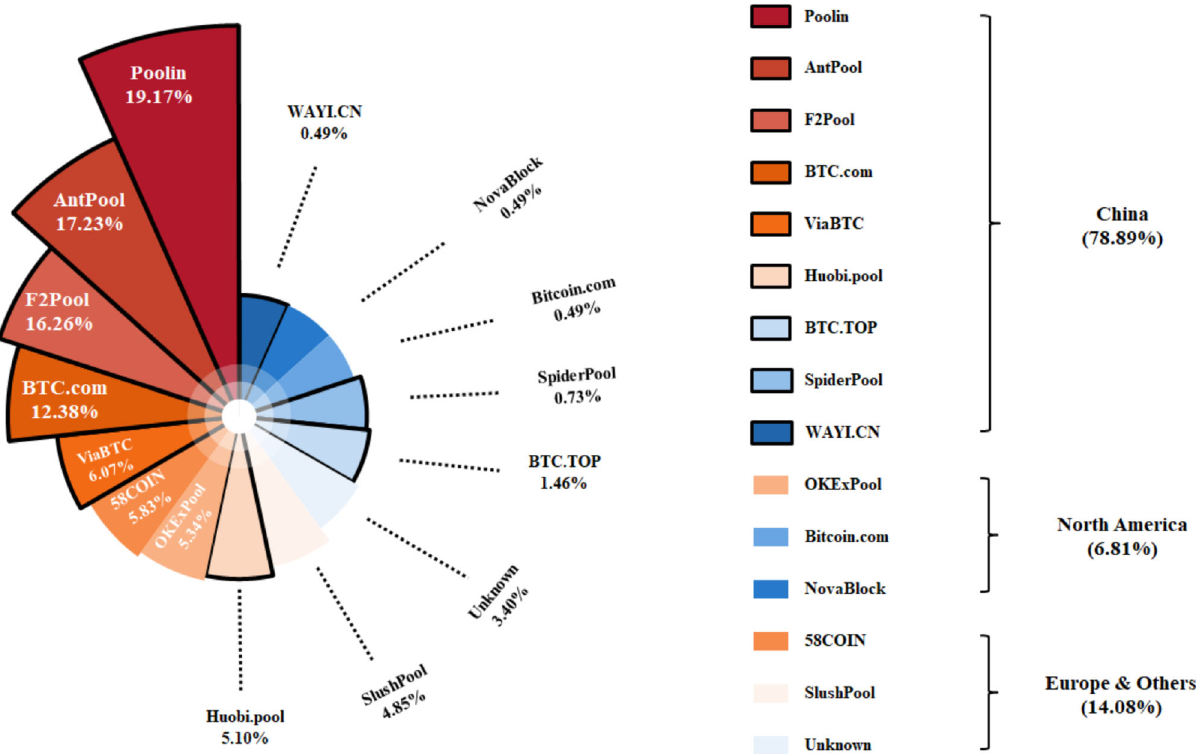
Fig. 1 Mining pool distributions of Bitcoin blockchain. As of April 2020, China accounts for more than 75% of Bitcoin blockchain operation around the world. Some rural areas in China are considered as the ideal destination for Bitcoin mining mainly due to the cheaper electricity price and large undeveloped land for pool construction. The mining pool statistics is obtained from https://btc.com/stats. Table 1 Scenario parameter settings.